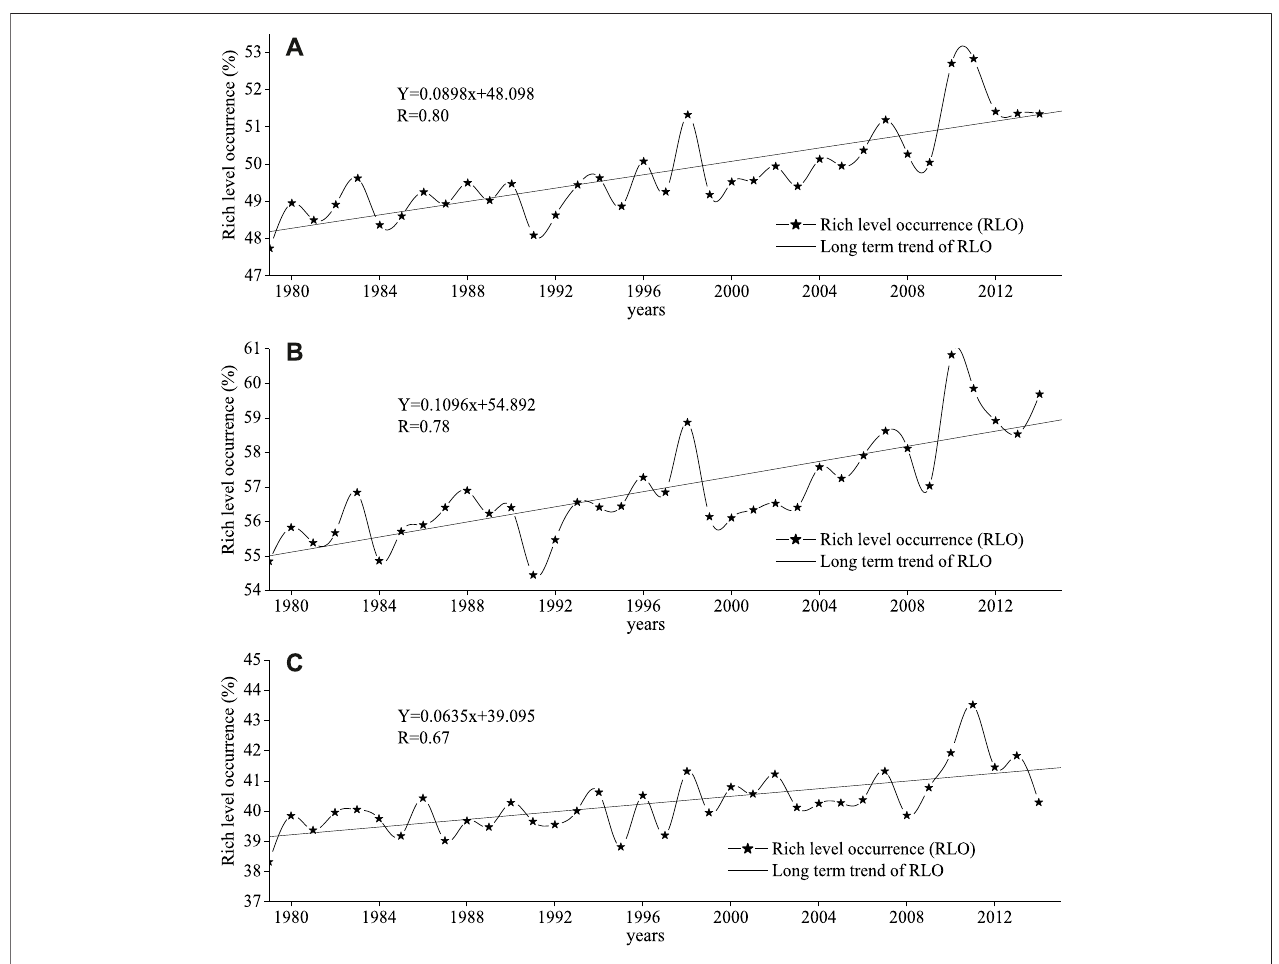
FIGURE4| Annualrichleveloccurrenceintheglobalocean (A) ,southglobalocean (B) ,andthenorthglobalocean (C) fortheperiod1979 – 2014andthelong-term trends.